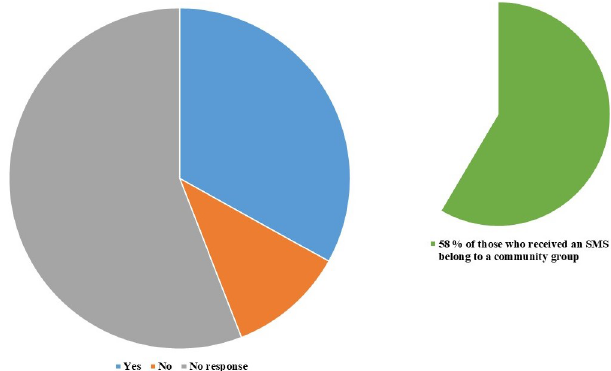
Figure 8. Percentage of community participants who have received an SMS text message warning; 58% of those who responded “yes” belong to a community